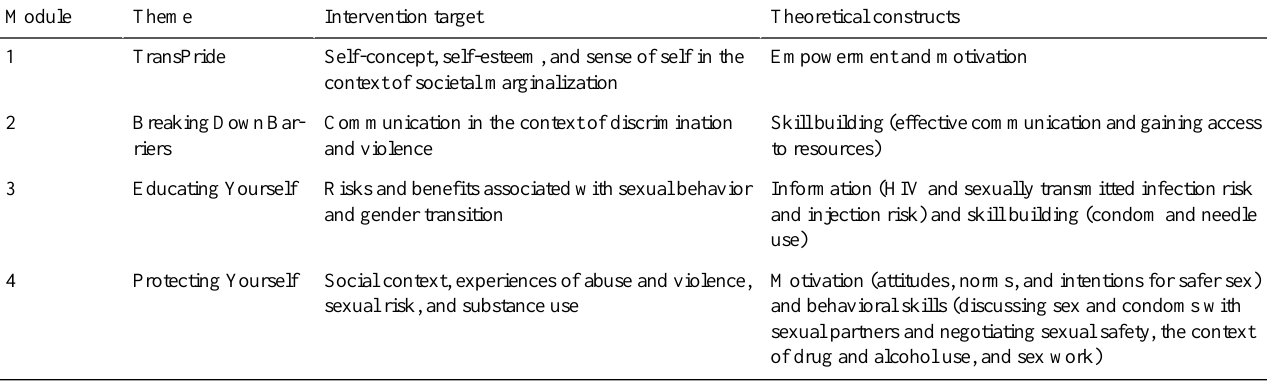
Table 1. LifeSkills Mobile themes, intervention targets, and